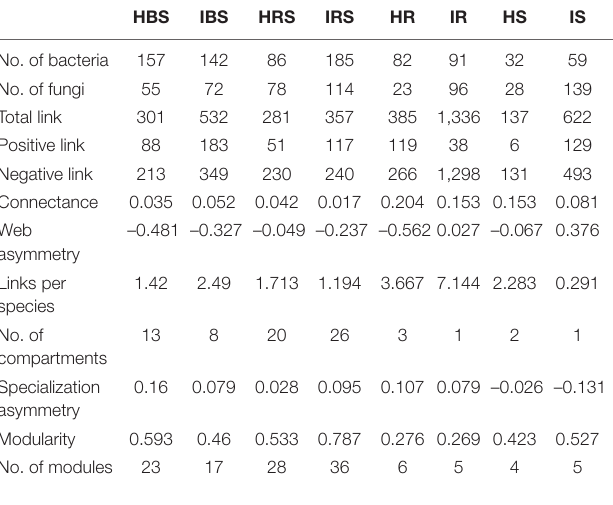
TABLE 2 | Interdomain network topology features of healthy and infected soil and endophytic microbial